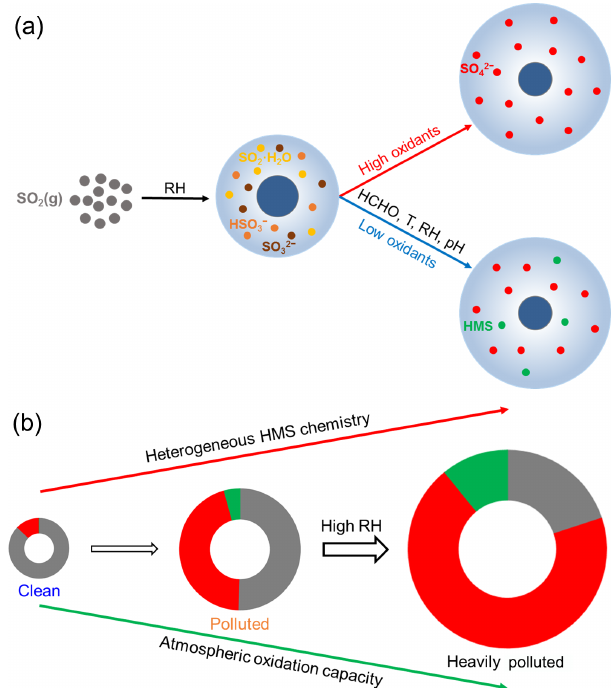
Figure 4. Schematic of the heterogeneous sulfur chemistry. (a) Ox- idation and addition reaction pathways of dissolved SO 2 in aerosol water under different atmospheric conditions. (b) Evolution of sulfur-containing species during winter haze deterioration in the NCP. With the increase in RH and decrease in atmospheric oxida- tion capacity under NCP winter haze, the atmospheric sulfur distri- bution shifts toward the particle phase and more particulate sulfur exists in the form of HMS. The gray, red, and green colors represent SO 2 , SO 2 − , and HMS, 4